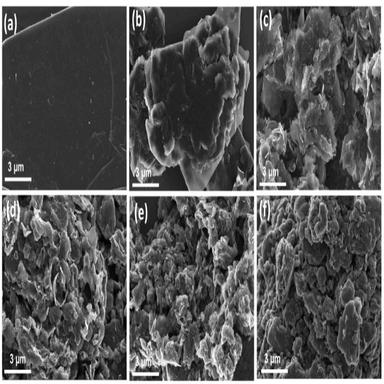
Secondary electron SEM images of pristine graphite (a), milled graphite (b), B-graphite (c), N-graphite (d), S-graphite (e), and I-graphite (f). XRD patterns (g) and Raman spectra (h) of the pristine graphite (i), milled graphite (ii), B-graphite (iii), N-graphite (iv), S-graphite (v), and I-graphite (vi).